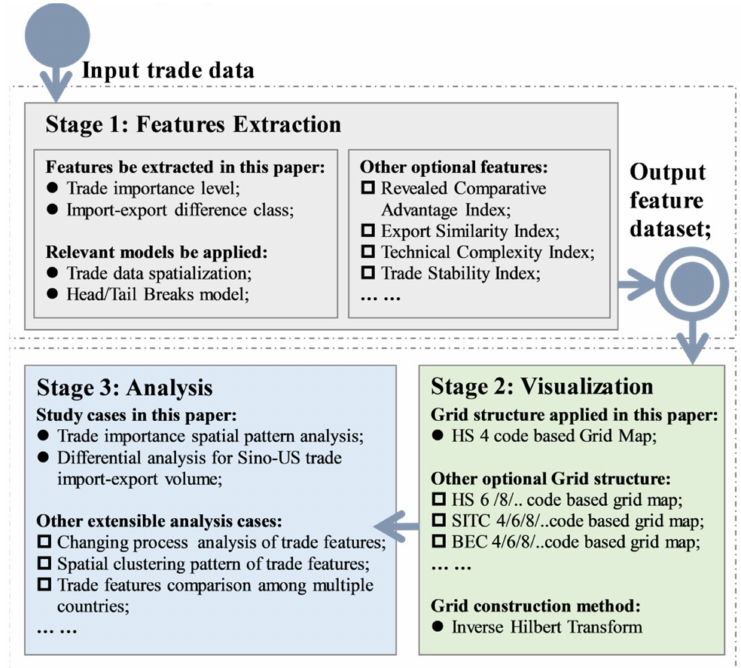
Figure 7. Extensible DTFM application